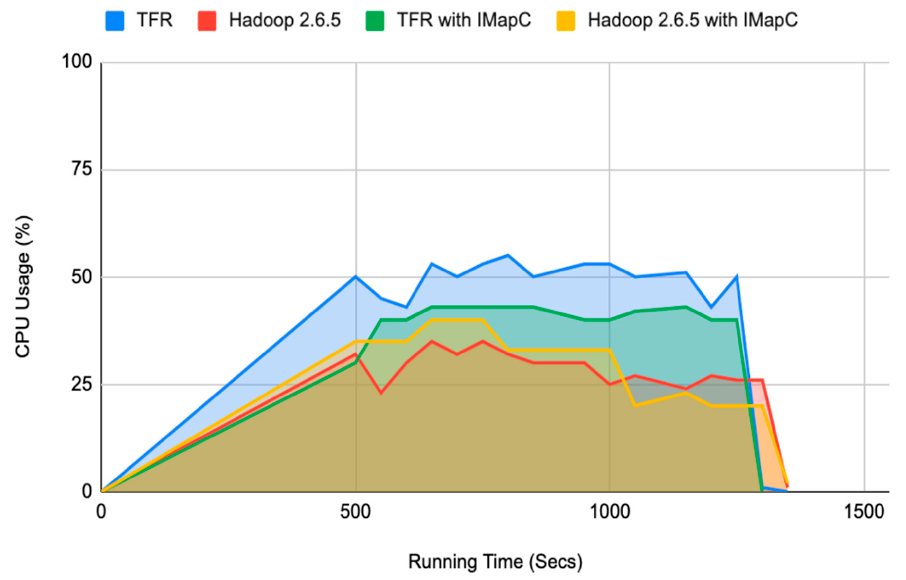
Figure 11. CPU usage on running Sort job for 35 GB.